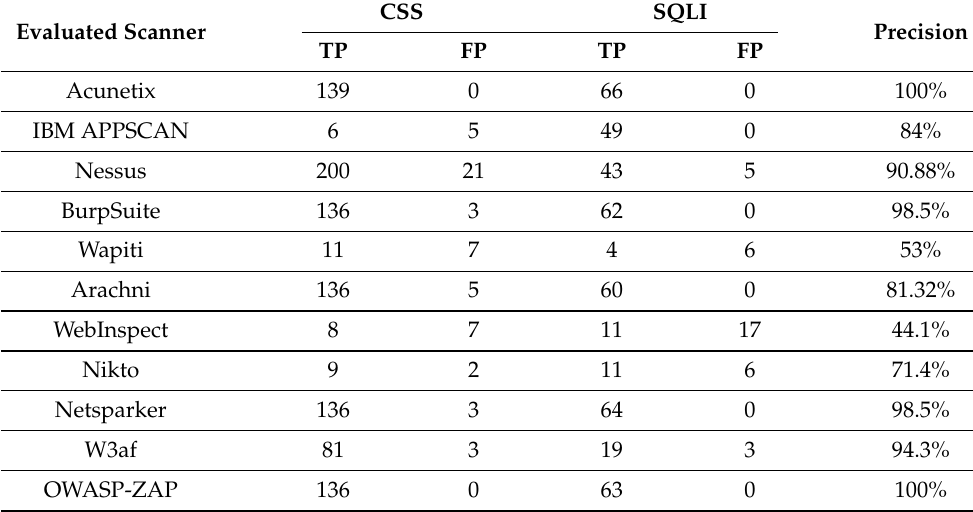
Table 5. Precision rate of evaluated